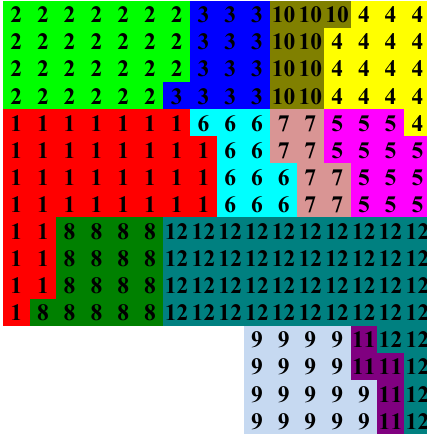
Fig. 14. The best solution obtain by QFA algorithm of Tavakkoli-Moghaddam et al. (2015) for Problem 2